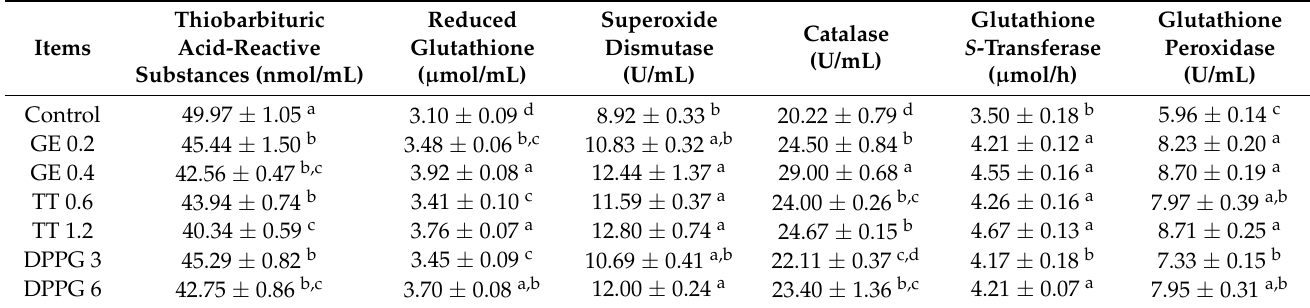
Table 3. Effect of different antioxidants supplementation (g/kg diet) on the levels of thiobarbituric acid-reactive substances, reduced glutathione, and the activities of antioxidant enzymes in testes homogenate of Nile tilapia, O. niloticus , fingerlings.